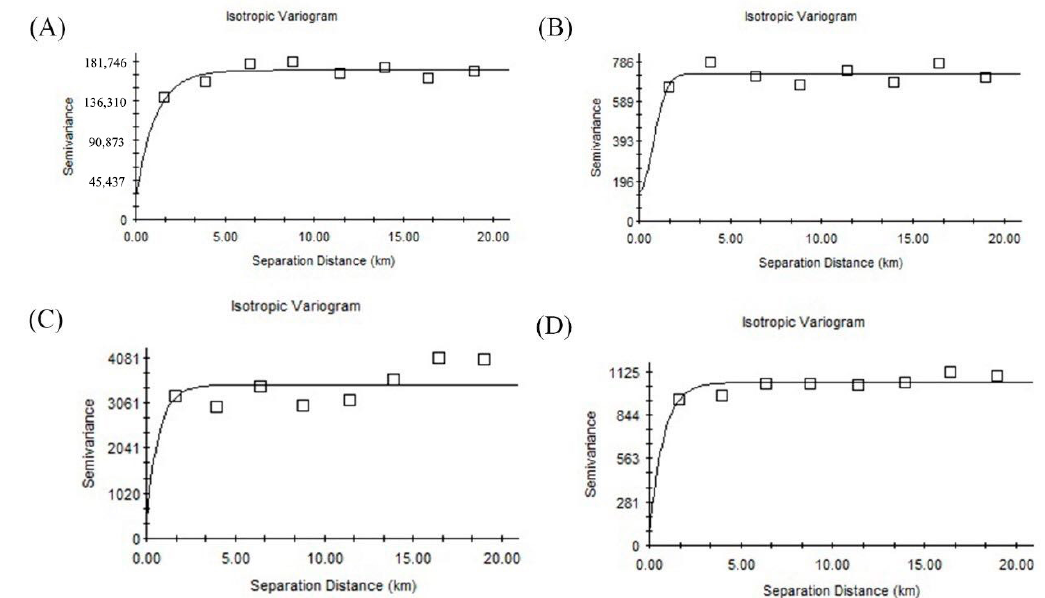
Figure 3. Semivariogram of TN ( A ); semivariogram of AP ( B ); semivariogram of AK ( C ); and semivariogram of ASi ( D ). The ranges of the variograms for AK, ASi, TN, and AP were 5530, 2400, 3300, and 2190 m respectively, which were lower than those reported previously on a similar regional scale [10,11]. Based on the notion that the sampling interval should be less than half compromise between the accuracy required and the resources available for investigation,